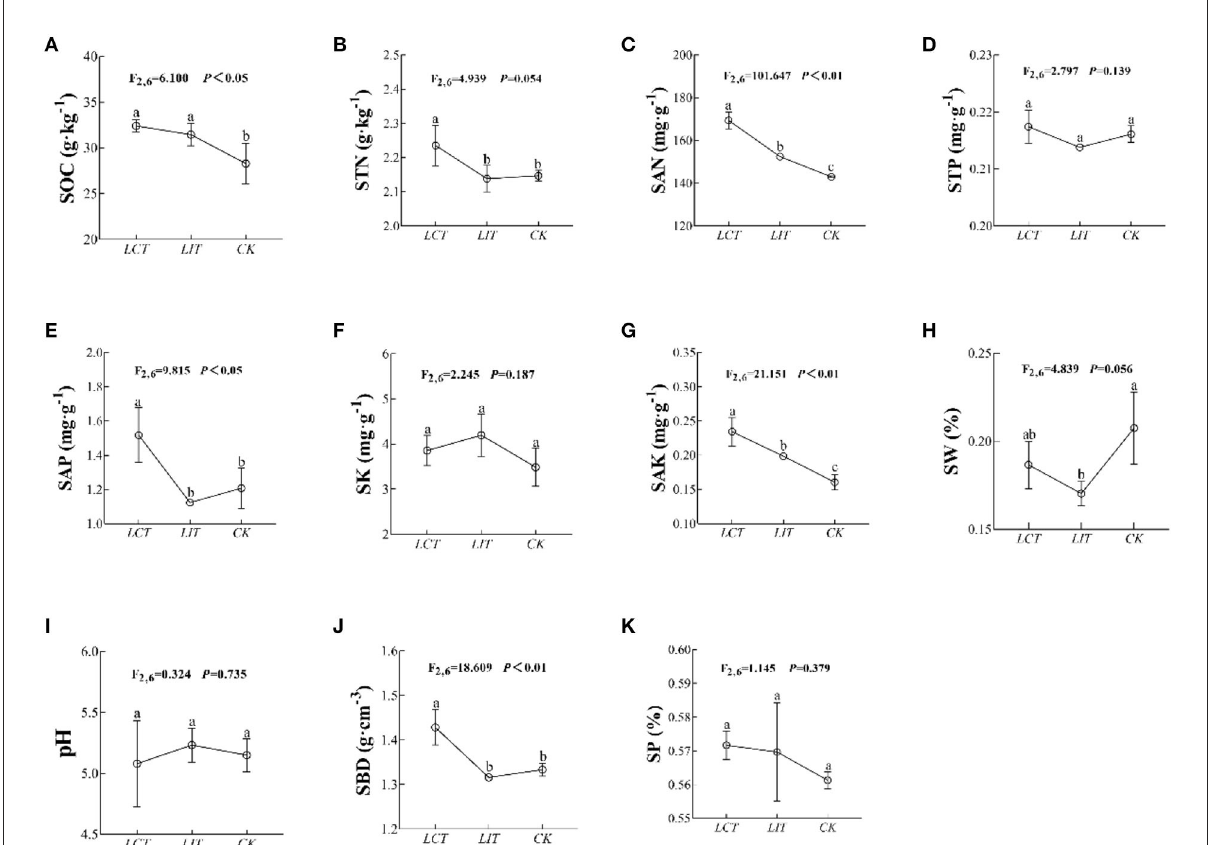
FIGURE3 The environment factors under the three treatments. The logging methods are LCT , logging of the competitive trees; LIT , logging of the inferior trees; CK , unlogged control. The soil parameters are SOC, soil organic carbon; STN, soil total nitrogen; SAN, soil alkaline nitrogen; STP, soil total phosphorus; SAP, soil available phosphorus; SK, soil total potassium; SAK, soil available potassium; SW, soil water content; pH, soil pH; SBD, soil bulk density; SP, soil porosity. Data shown are the mean ± standard deviation ( n = 3). Different lowercase letters indicated significant differences among the treatments ( p < 0.05) in (A–K) .